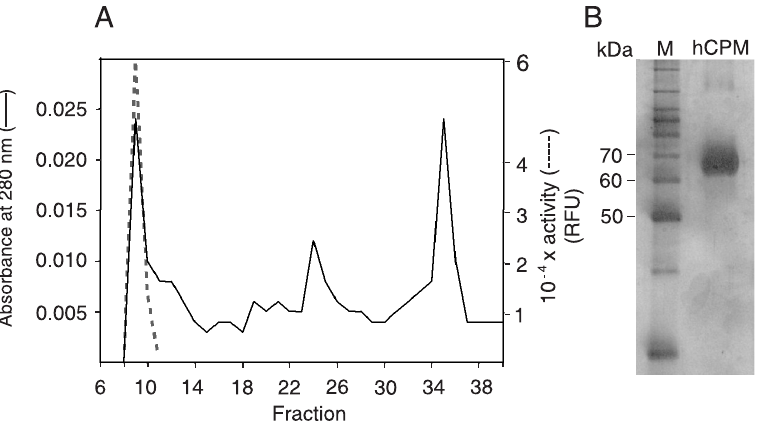
Figure 4. A , Ion-exchange chromatography. A pool of effluent containing enzyme activity (0.28 mg/mL in 1.5 mL) obtained by gel filtration (Figure 3) was loaded onto a Mono Q HR 5/ 5 column equilibrated with 50 mM Tris-HCl buffer, pH 8. The column was washed with equilibration buffer and then eluted with a linear gradient (0 to 1 M) NaCl in the same buffer. Proteins were detected by UV absorption at 280 nm. Fractions of 0.5 mL were collected and assayed for carboxypeptidase M activity. RFU = relative fluorescence units. B , SDS-PAGE (12%) of pooled active fractions. M, molecular mass markers (Bench Mark Protein Ladder, Invitrogen). Human carboxypeptidase M (hCPM) appears as a diffuse band because it is a glycoprotein. Table 1. Purification of recombinant hCPM from 1 mL of fermentation supernatant. Step Protein Total Specific Purification (mg) activity* activity** (X-fold) Supernatant Superdex 200